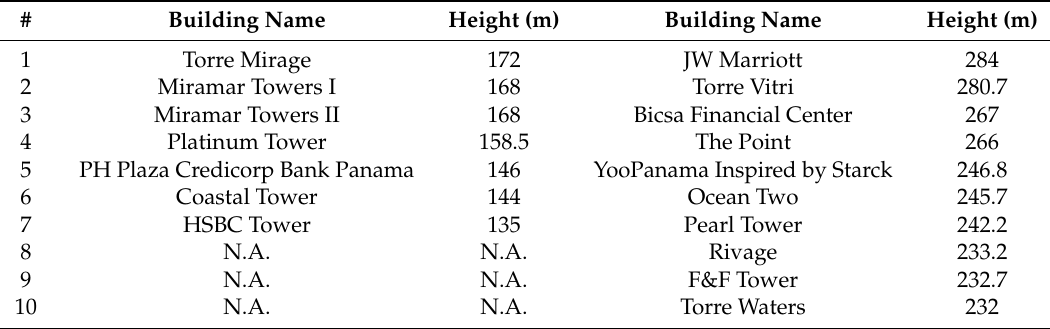
Figure 20. Panama City in 2000 and 2020. Table 30. Panama City’s 10 tallest skyscrapers in 2000 and 2020.